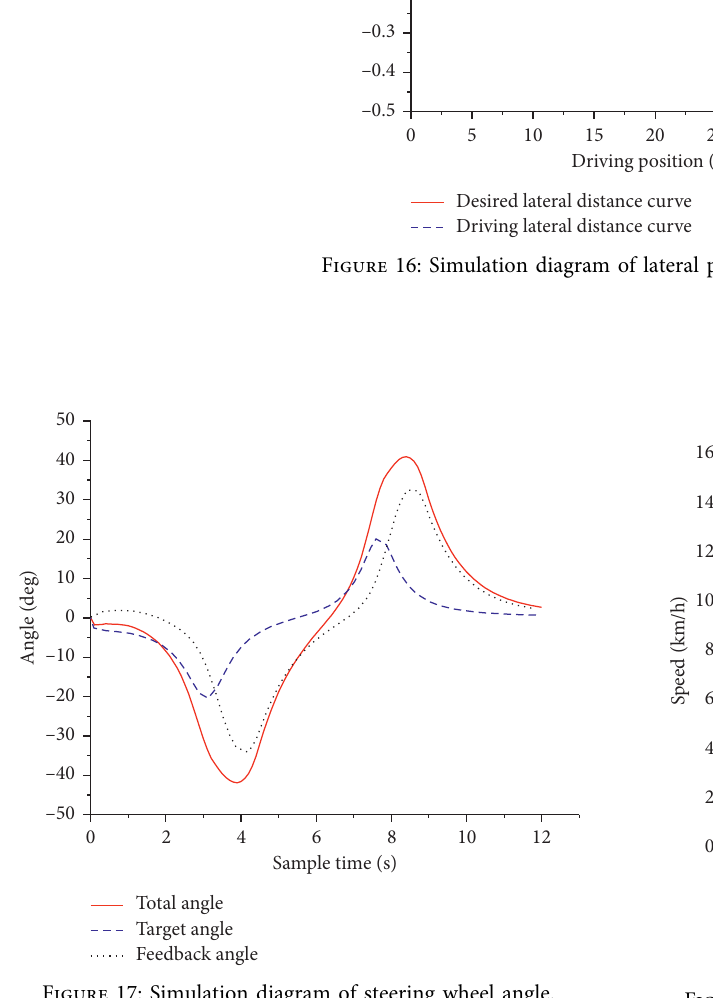
18: Running speed tracking simulation